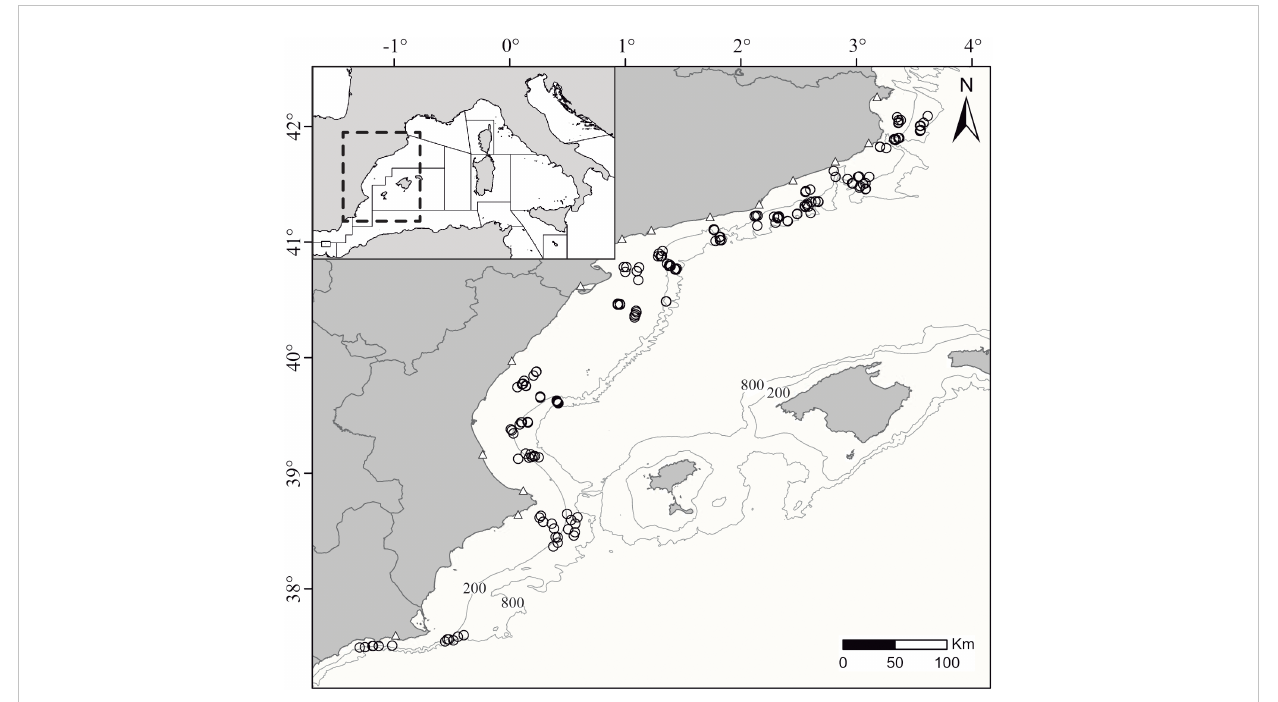
FIGURE 1 Geographical position of the study area within the western Mediterranean including the respective existent Geographical Sub-Areas (GSAs). The points indicate the position of the 189 fi shing hauls analyzed in this study occurring across the GSA06 (Northern Spain) at depths ranging from 50 to 800 m. The triangles denote the location of the home ports included in the study and the isobaths denote 200 and 800 m